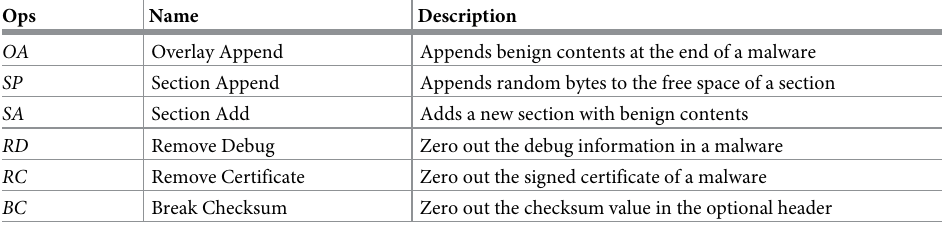
Table 2. The mutation operations of